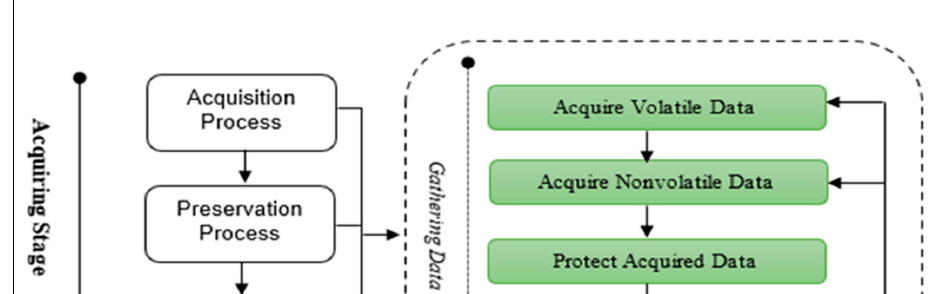
Figure 6. Initialization stage.